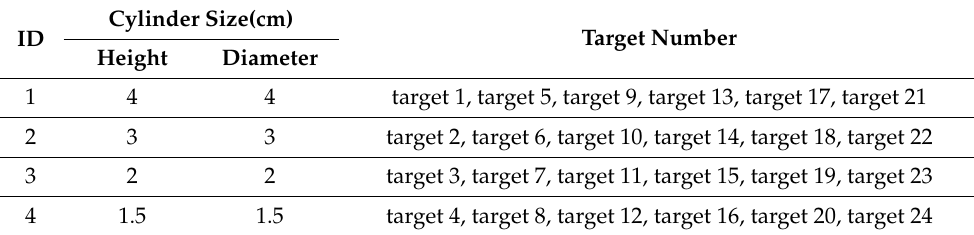
Figure 12. Layout diagram of cylindrical targets on the runway. Table 1. Correspondence table between cylinder size and target number.